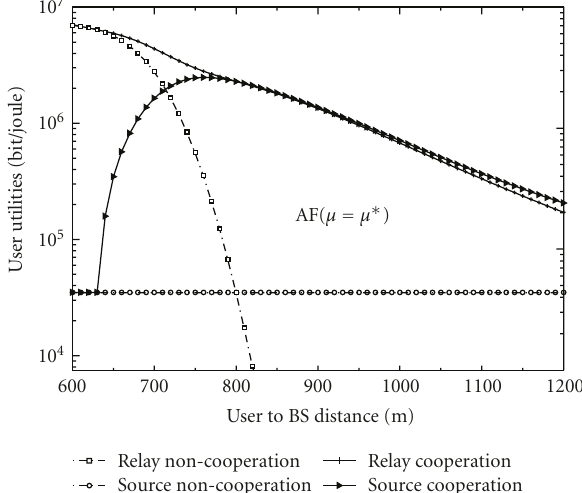
Figure 3: User utilities with the proposed strategy under AF for- warding.